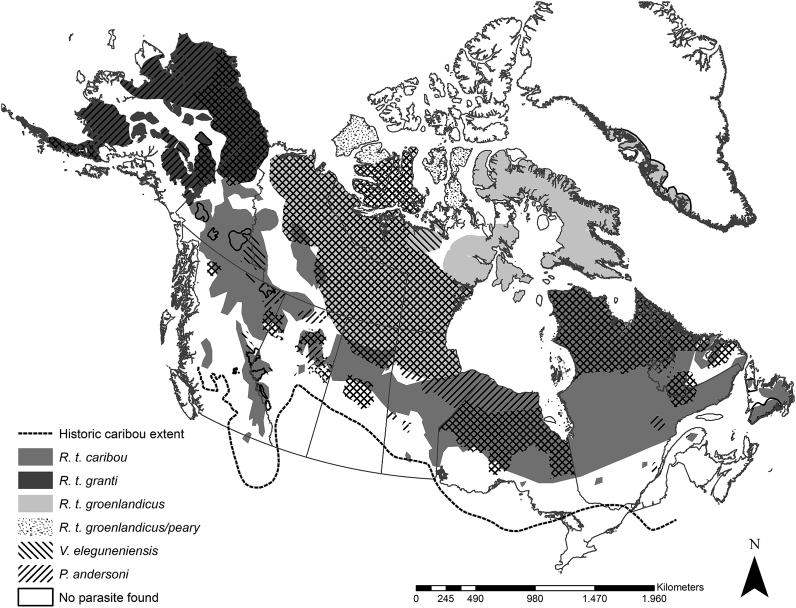
Map of Northern North America, including Alaska, USA, Canada and Greenland depicting the geographic distribution of caribou subspecies (Rangifer tarandus sspp.). The distribution of the caribou lungworm, Varestrongylus eleguneniensis, and the muscleworm, Parelaphostrongylus andersoni in caribou is shown based on compiled data from the present study, and all reports in the literature (Lankester and Hauta, 1989; Lankester and Fong, 1998; Kutz et al., 2007, 2012; 2013; Verocai et al., 2013; Kafle et al., 2017a, Kafle et al., 2017; Turgeon et al., 2018). The historic southern range of distribution of caribou is shown as a dotted line to assist in the discussions on the historical biogeography of V. eleguneniensis and Rangifer. (See Fig. S1 and Fig. S2 for the distribution maps for V. eleguneniensis and P. andersoni separately).